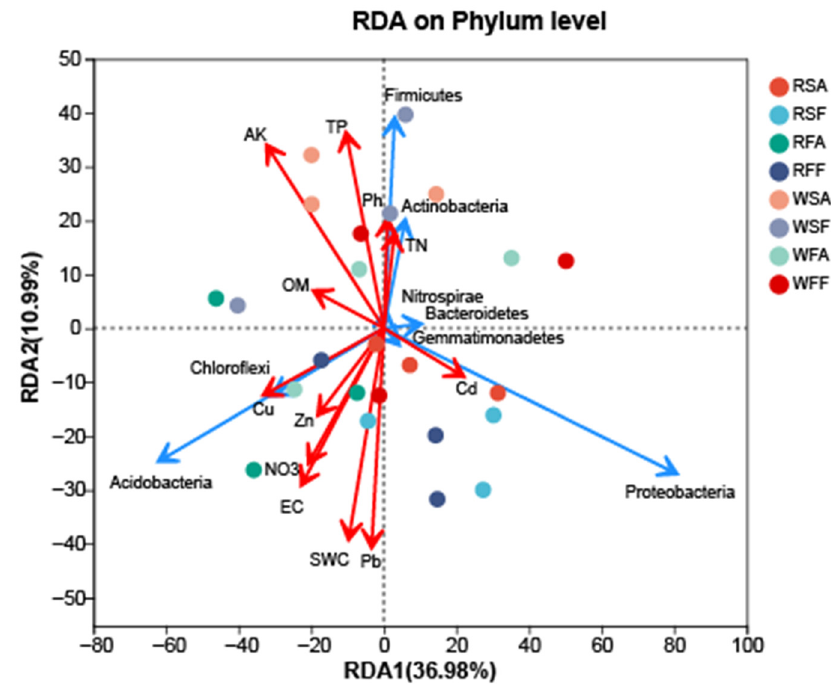
Figure 5. Redundancy analysis of bacterial communities and environmental factors.